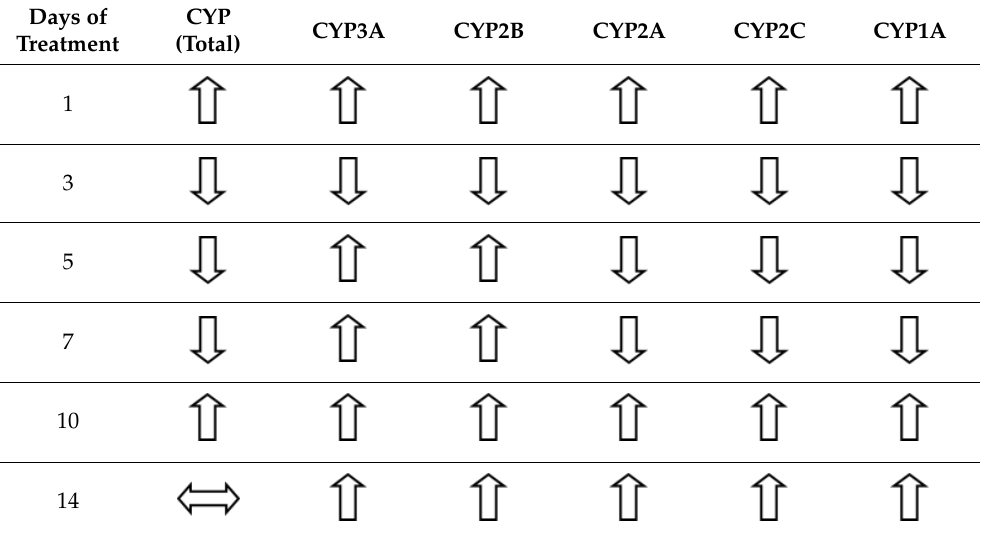
Table 4. The effect of chronic administrations of cocaine (60 mg/kg ip. for 14 days) on total cy- tochrome P450 (CYP) content and activity of selected CYP enzymes in DBA/2/KUO (D2) male mice. ergic receptors on the activity and protein levels of cytochrome P450 (CYP) isoforms in rat liver microsomes. Days of